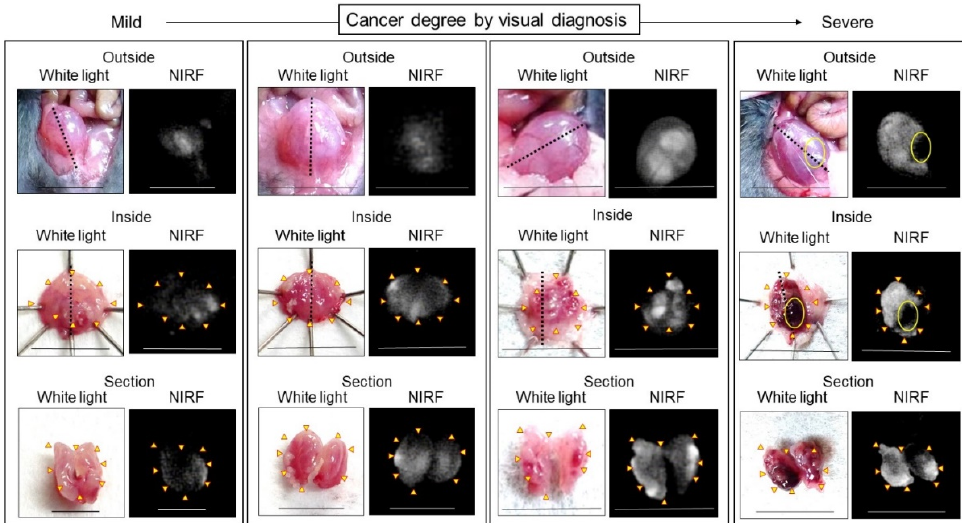
Figure 5. Representative near-infrared fluorescence (NIRF) imaging of MB49 bladder cancer in mice after intravesical administration of ASP5354. ASP5354 (2.4 μ M) was injected in cancerous bladder, 5 min after which, the cancerous bladder was rinsed with saline 5 times, filled up with saline, and NIRF imaging was performed from outside the bladder. After imaging, the bladder was picked out and opened along the black dotted line. NIRF in the obtained bladder inner layer was imaged. All excitation levels are 10 a.u. NIRF is displayed in white. Scale bar represents 10 mm. Yellow arrows show points of boundary between NIRF and non-NIRF. Yellow circles in photos for Severe degree (Outside and Inside) show severe blood clot. Bladder (for Outside, Inside, and Section) in each frame is identical.